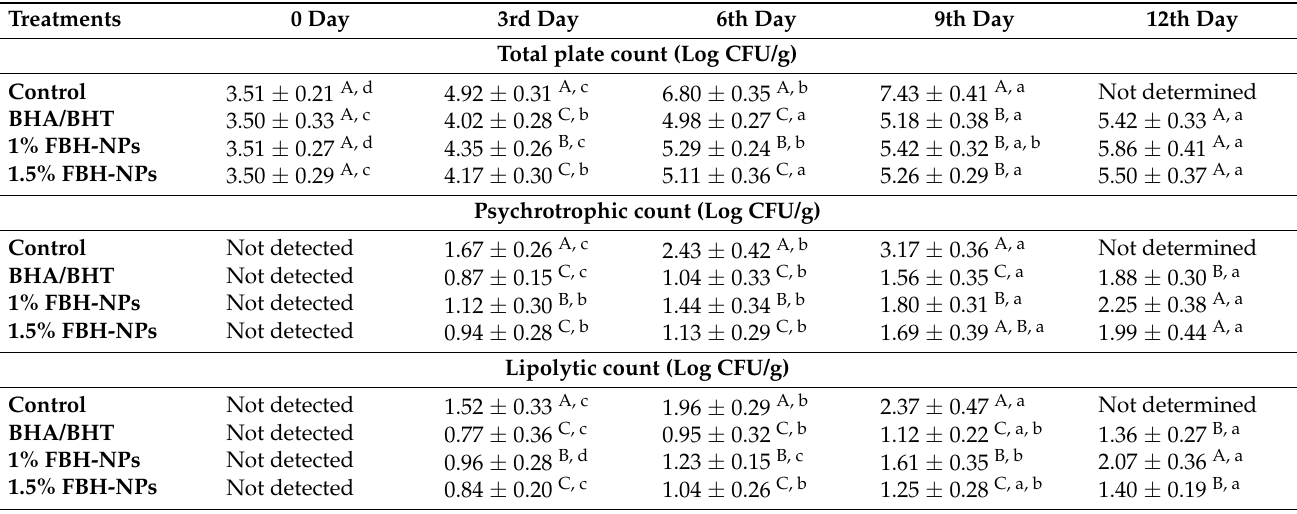
Table 5. Effect of adding FBH-NPs on microbiological load (Log CFU/g) in burgers during refriger- ated